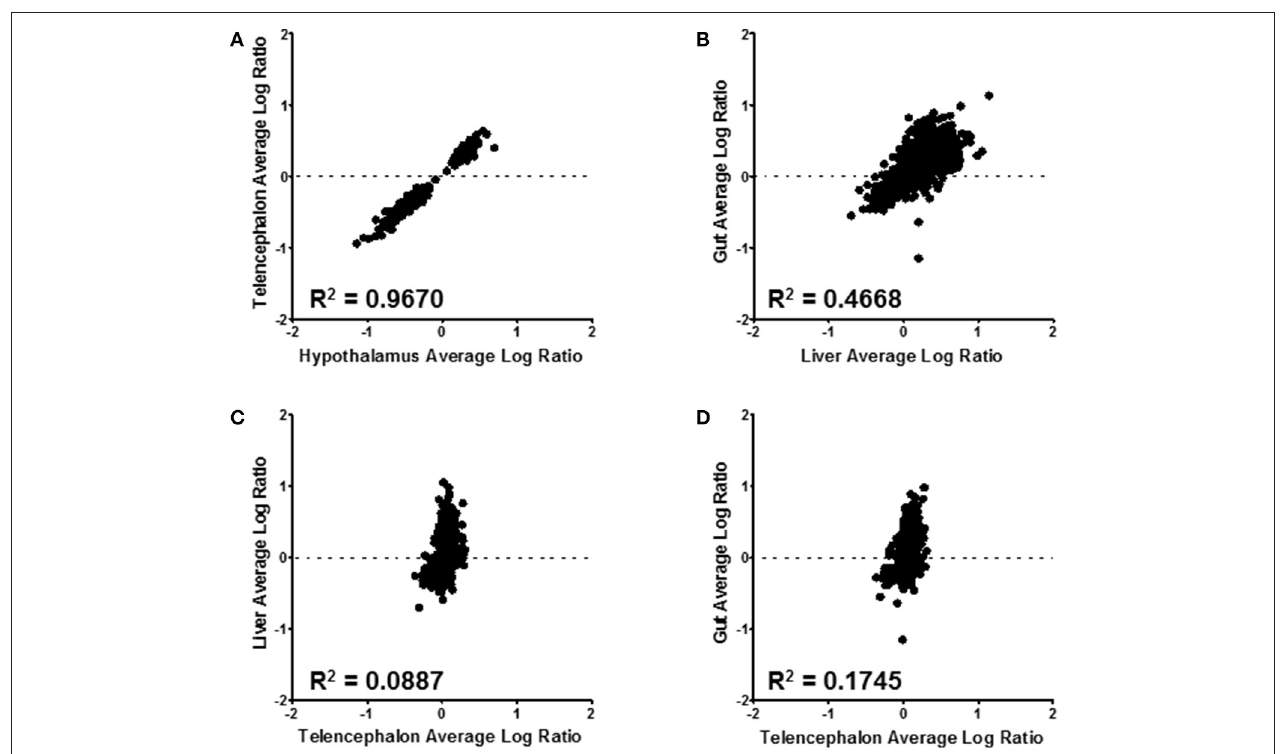
FIGURE 6 | Tissue level comparisons of all confidently quantified protein ratios. All tissue comparisons had a p -value ≤ 0.001. Hypothalmus to telencephalon correlation was made by using the liver as the denominator of the ratio calculation (A) ; while the gut to liver (B) , liver to telencephalon (C) , and gut to telencephalon (D) were made using the hypothalamus as the normalizing tissue. The R 2 value for each correlation is displayed on the corresponding graph.